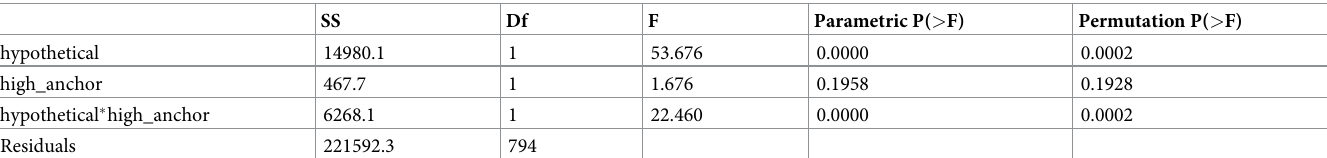
Table 15. Experiment 3: Permutation